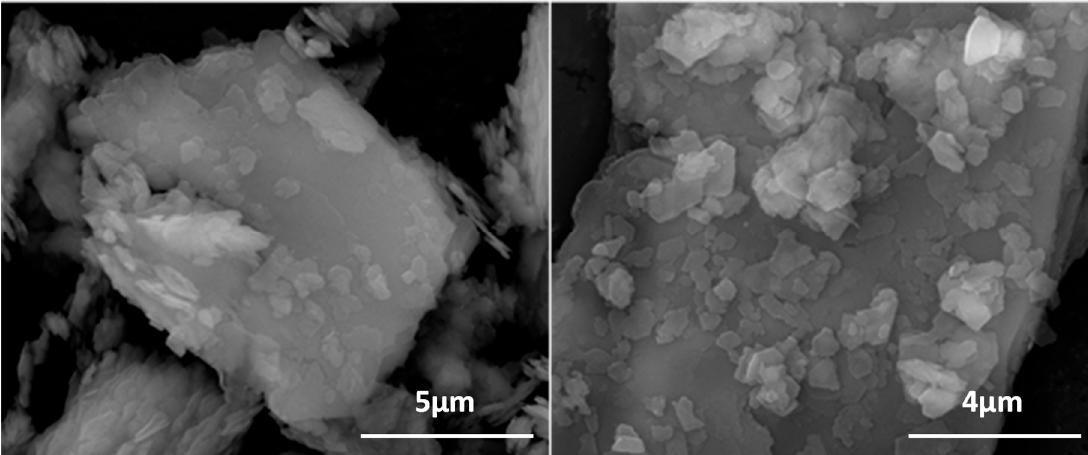
Figure 1. Kaolinite ( left ) and mica ( right ) crystals: superficial